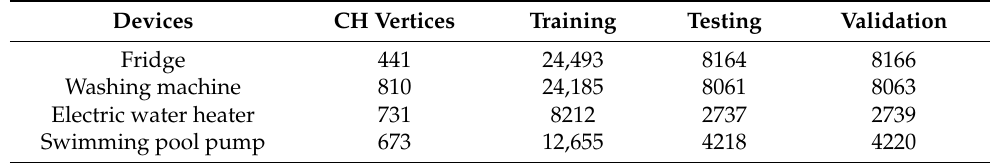
Table 2. Approxhull results for classification.